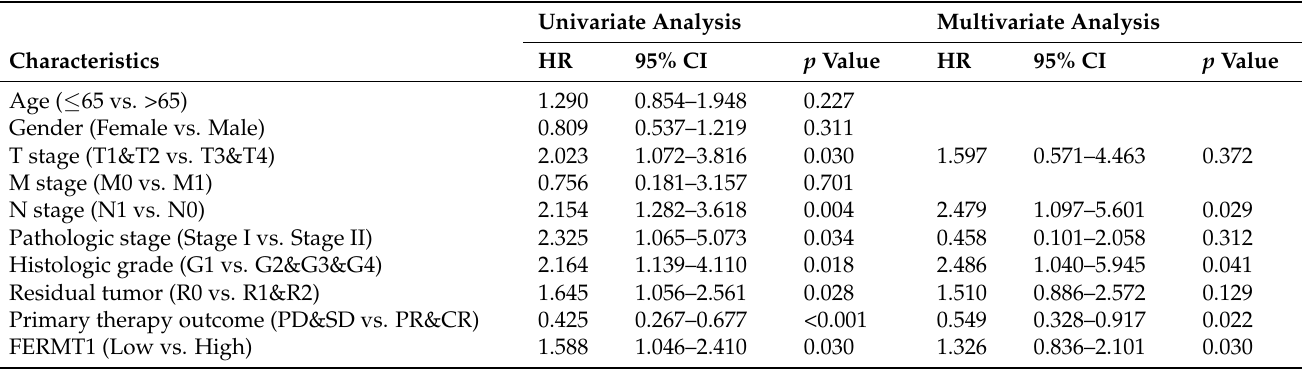
Figure 2. The correlation between FERMT1 expression and clinicopathological parameters. High FERMT1 expression was significantly related to ( A ) T stage, ( B ) N stage, ( C ) M stage, ( D ) pathological stage, ( E ) histological type, ( F ) primary therapy outcome. PD, progressive disease; SD, stable disease; CR, complete response; PR, partial response. * p < 0.05, ** p < 0.01, ns, no significant difference. Table 1. Univariate and multivariate Cox regression analysis of FERMT1 expression for overall survival in patients with